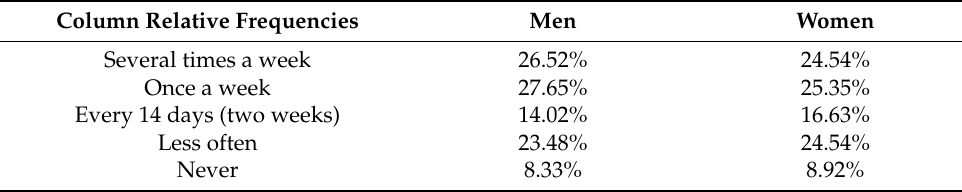
Table 7. Contingency table, Supermarkets & Respondent’s gender.